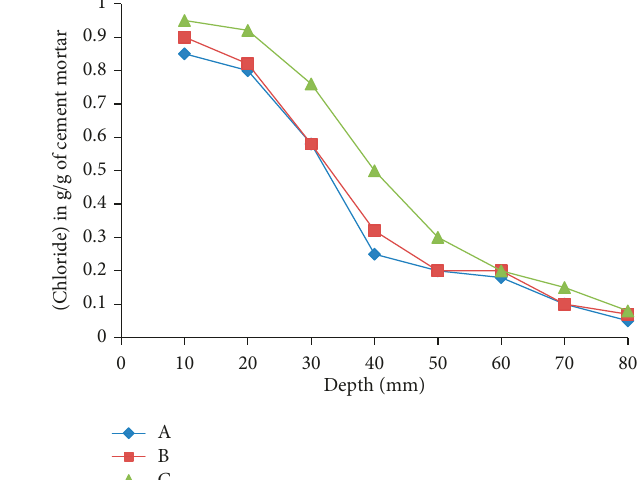
Figure 12: Chloride profiles at w/c 0.5.